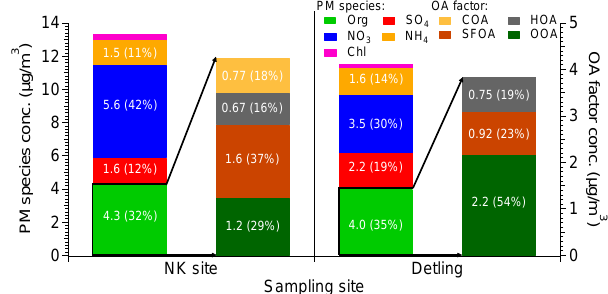
Figure 6. Comparison between NK and Detling sites in terms of the campaign-averaged concentration and mass fraction of non- refractory species and OA factors. The unexplained mass by PMF analysis is less than 6% of total OA and not shown in the